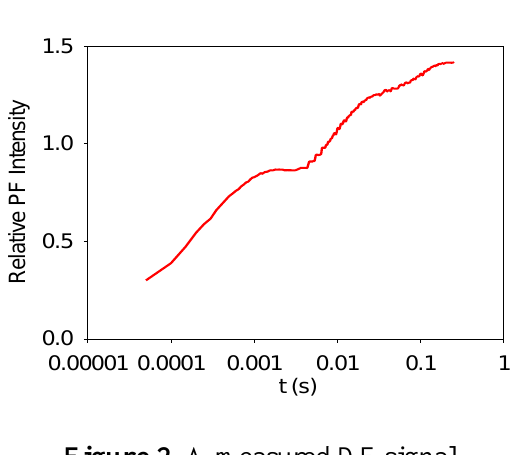
Figure 2. A measured DF